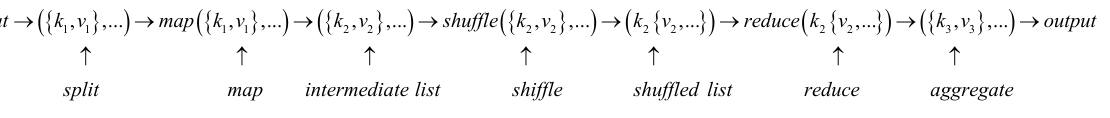
Figure 5. A typical MapReduce workflow shuffled